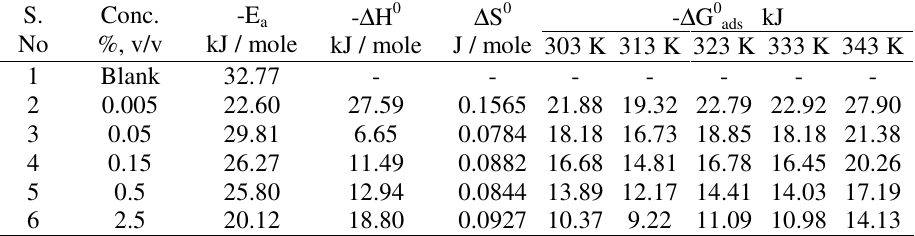
Table 4. Activation parameters for the dissolution of mild steel in the presence of CAL in 1 M HCl.